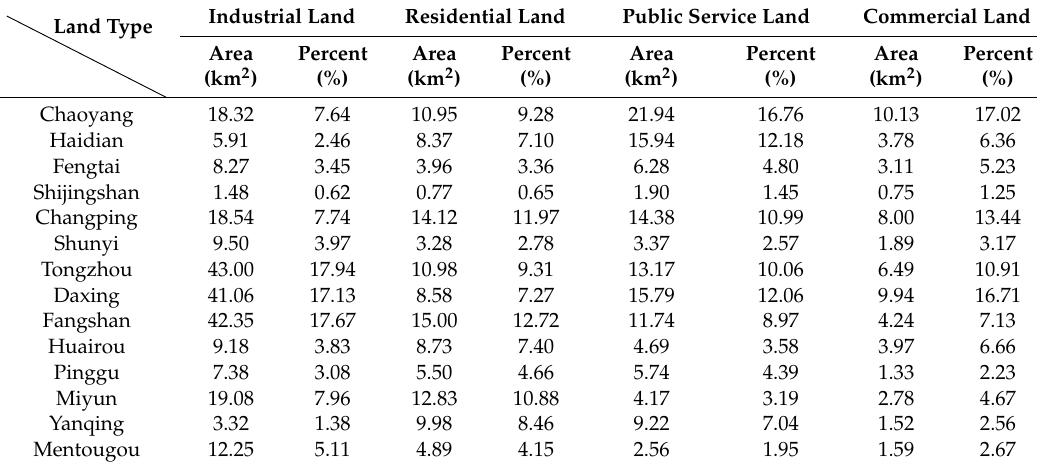
Table 5. Statistics of the newly added construction land in di ff erent districts in Beijing from 2001 to